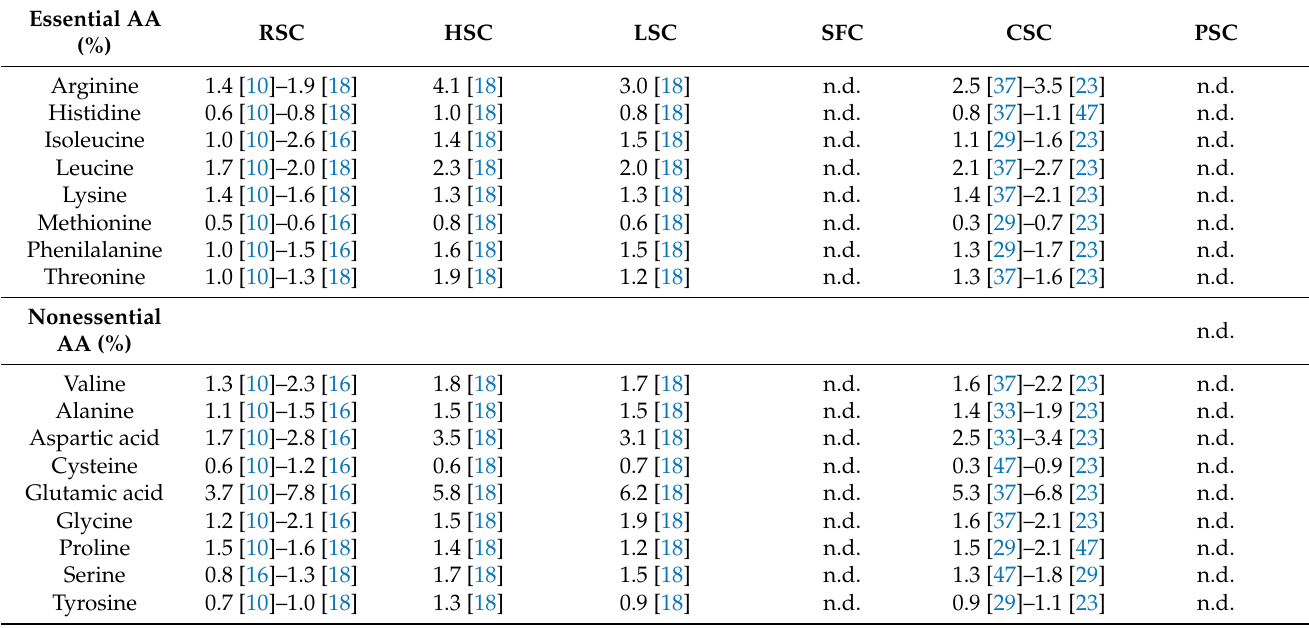
Table 2. Amino acid (AA) profile (% as-fed basis) of cold-pressed oilseed